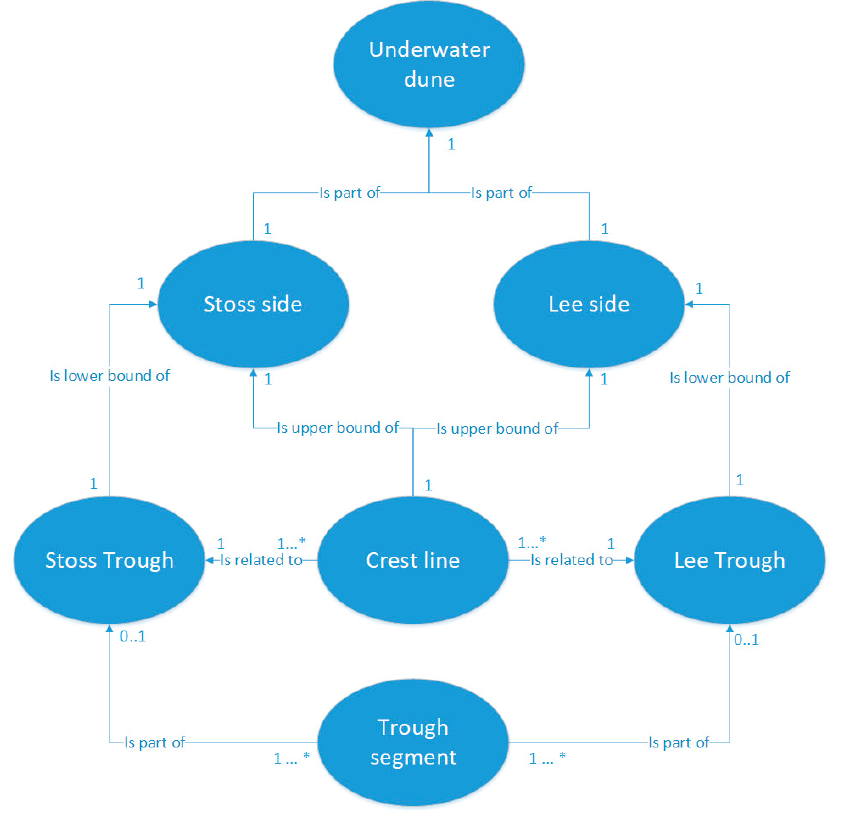
Figure 4. Conceptual model of underwater dunes.